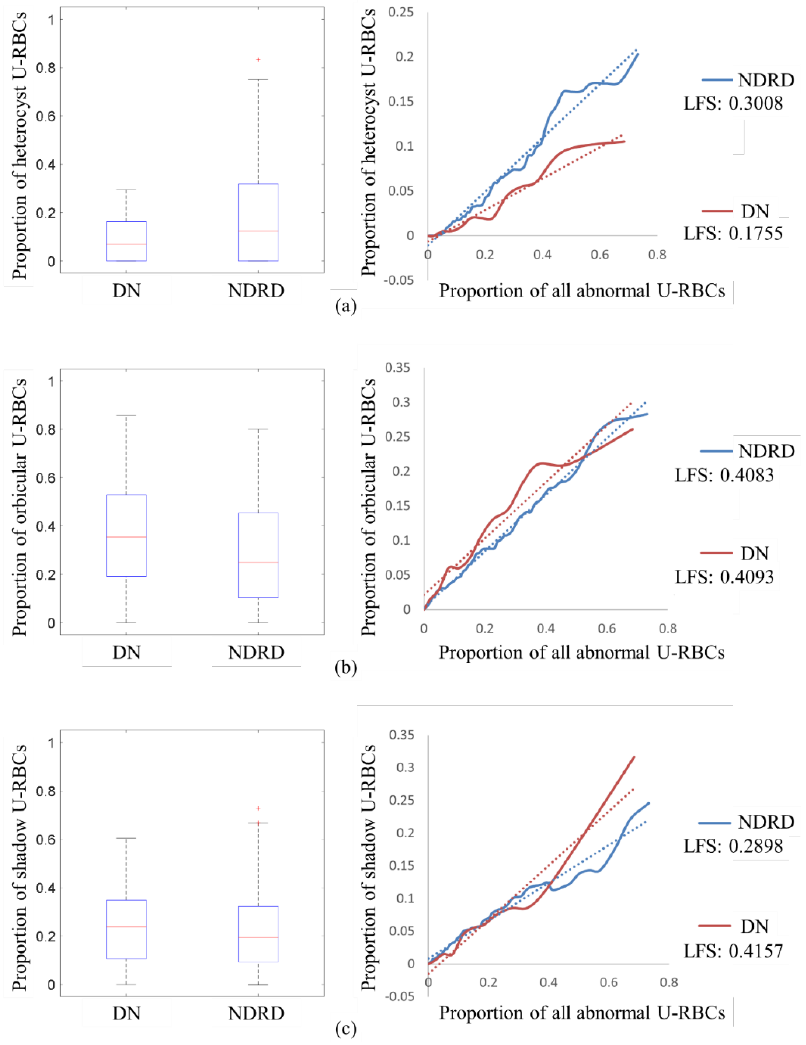
Figure 8. The box diagram and growth trend diagram of heterocyst, orbicular, and shadow URBCs in DN and NDRD. ( a ) The box plot and growth trend of heterocyst U-RBCs; ( b ) The box plot and growth trend of orbicular U-RBCs; ( c ) The box plot and growth trend of shadow